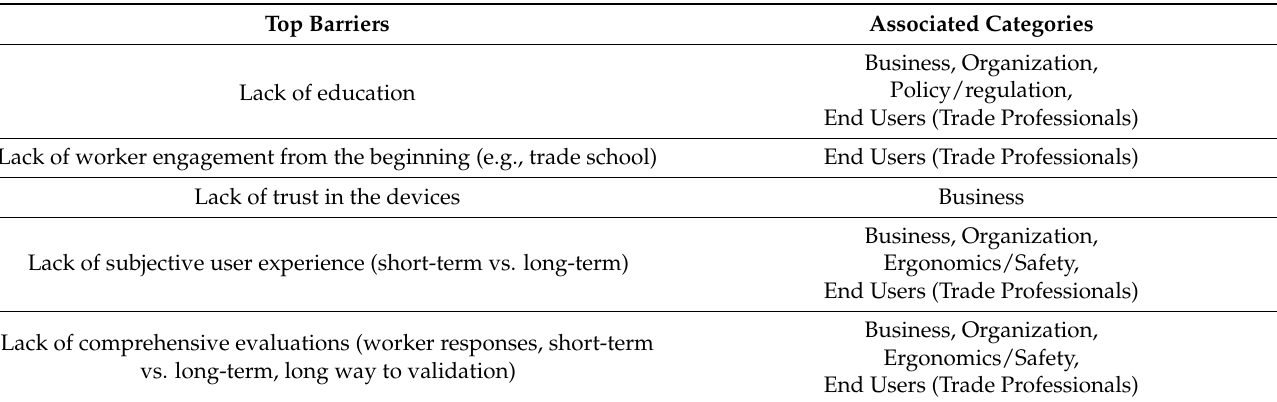
Table 9. Top barriers identified by the expert panel with associated